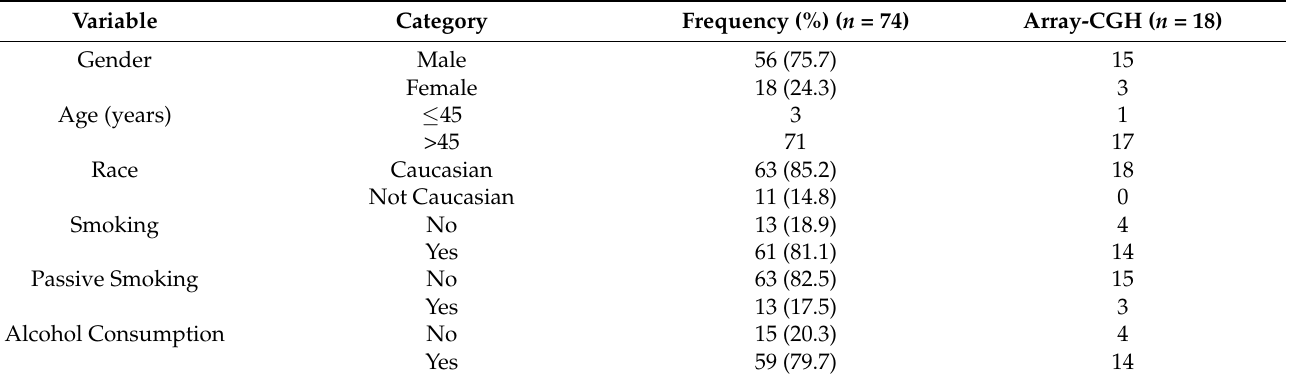
Table 1. Epidemiological and clinical characteristics of 74 index patients, including 18 evaluated by